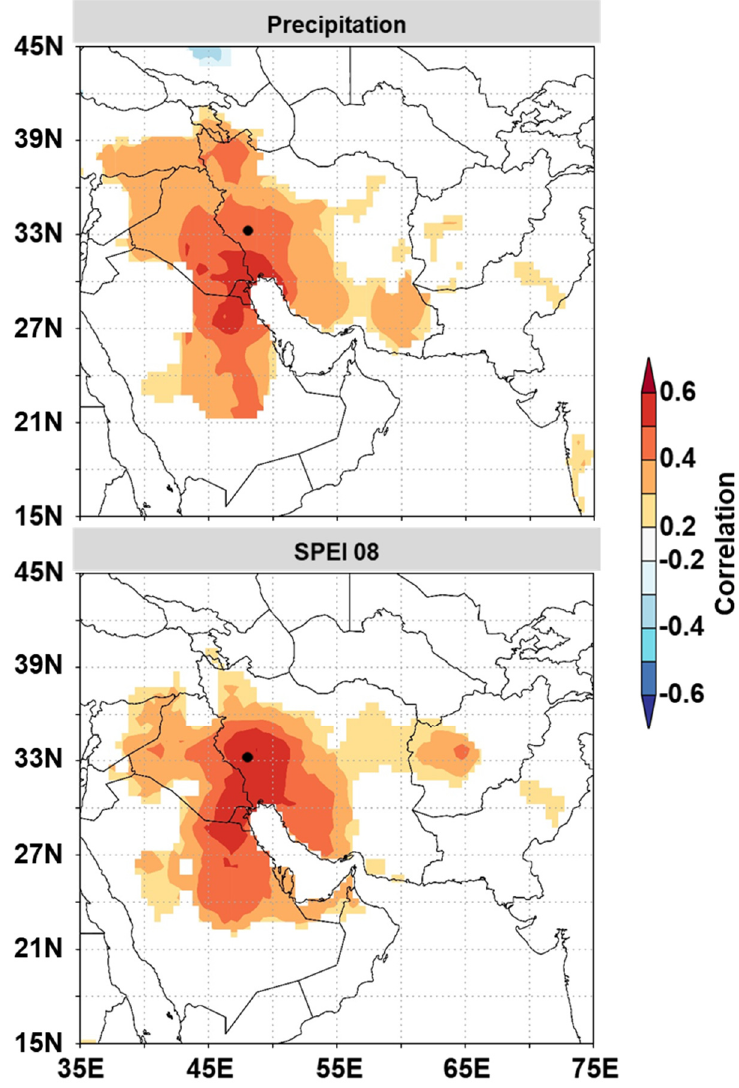
Figure 9. Spatial correlation maps between the first PC (i.e., PC1 scores) and April–September climatic variables using a resolution of 0.5° × 0.5° gridded cells for the common 1963–2011 period: upper map represents the correlation with precipitation (CRU TS4.04 land), and the lower map represents the correlation with drought (CSIC SPEI 08). The black dot indicates the location of the three sampling sites within the Central Zagros Mountain.